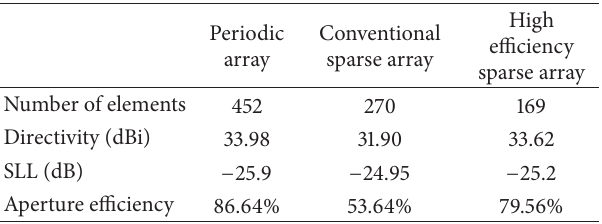
Periodic Conventional array sparse array